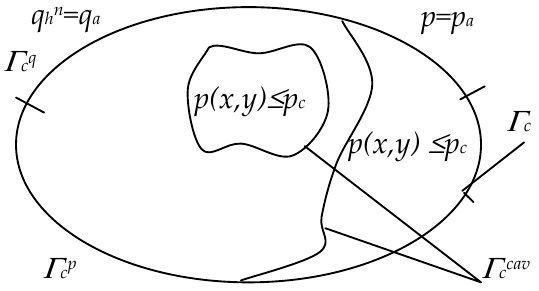
Figure 2. Boundaries of the contact zone and the cavitation edge.